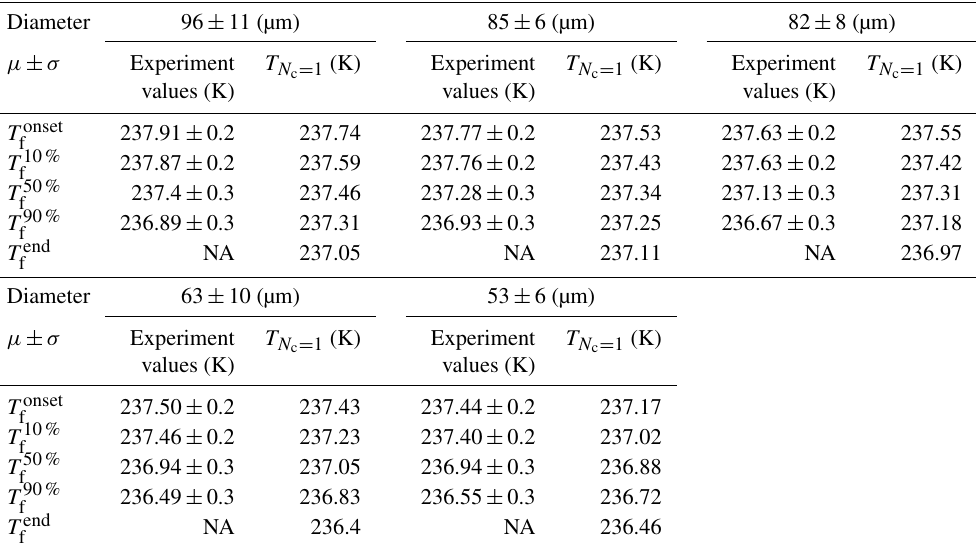
Table 2. Comparison between the experimental results of the fraction experiment from Riechers et al. (2013) and the theoretical estimates T N derived c = 1